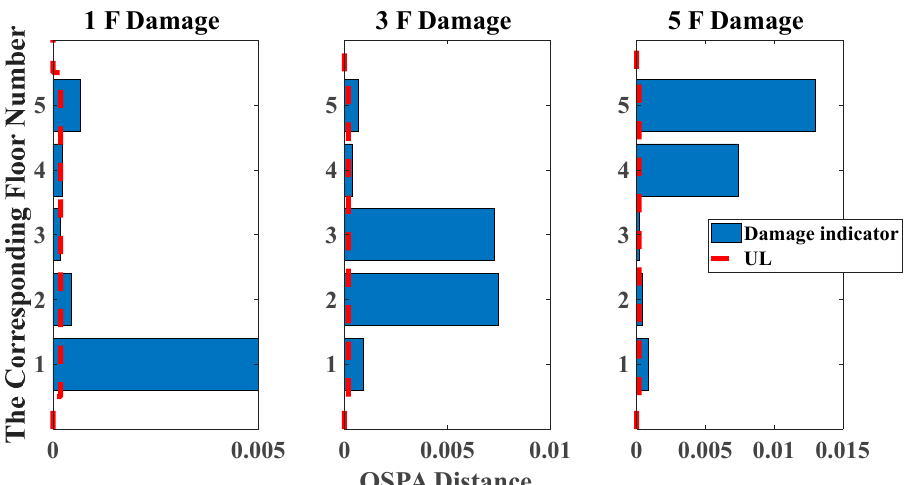
Figure 28. Damage detection results based on the OSPA distance (removing central columns, white noises excitation, autoregressive model, data length = 4000, AR order = 2, OSPA.p = 2).